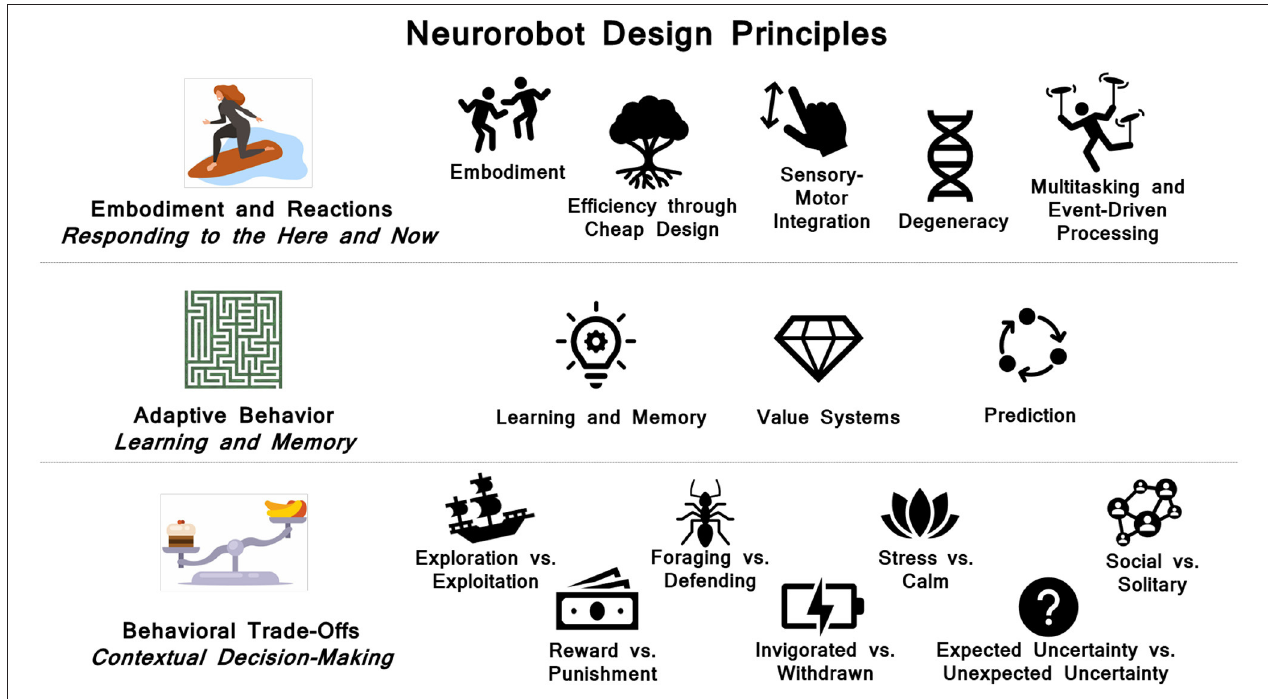
FIGURE 11 | Summary of neurorobot design